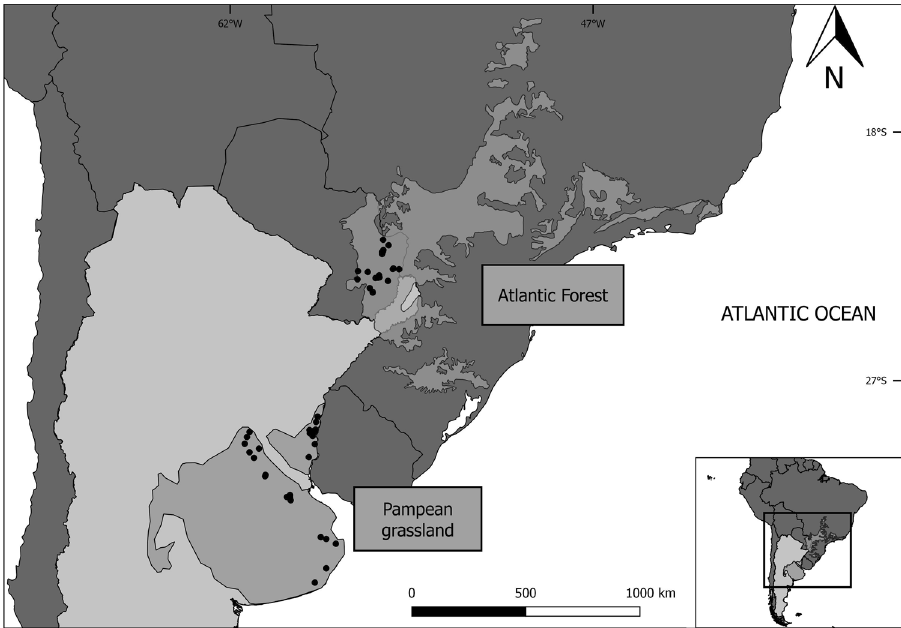
Figure 1. Location of the 27 sampling sites in the Pampean grassland (Grassland biome) and 22 sites in the Atlantic Forest (Forest biome). This map was generated with QGIS (3.28 Firenze version), a free and open- source Geographic Information System (https:// www. qgis.